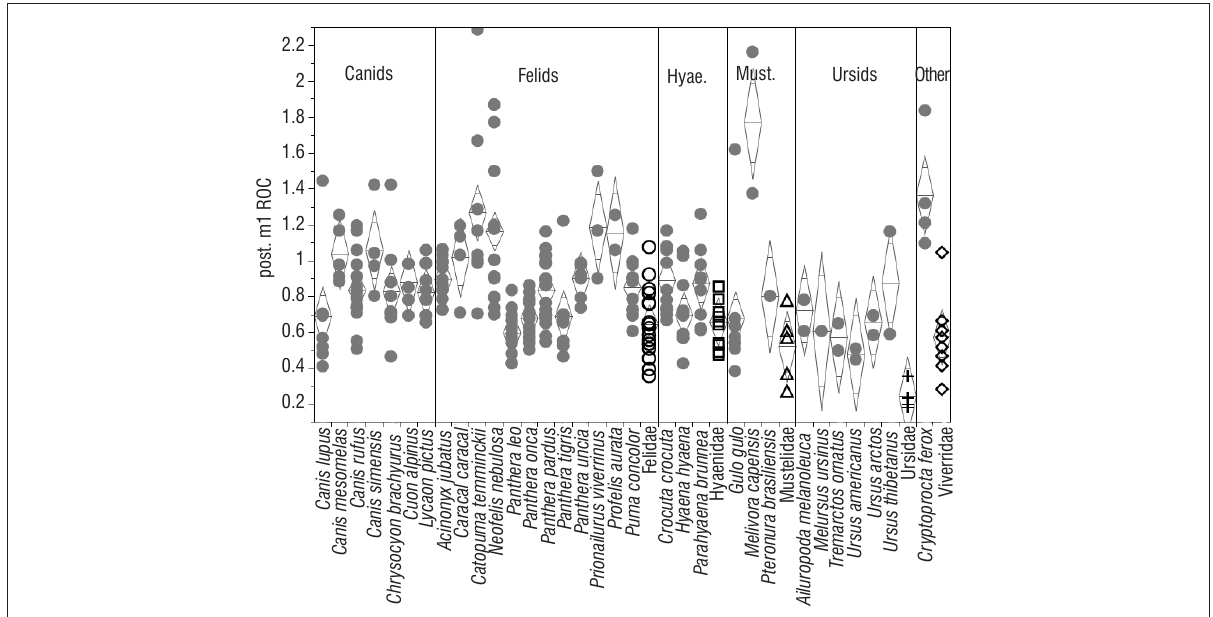
Extant taxa are represented by solid grey circles, Langebaanweg (LBW) felids by open circles, LBW hyaenids by open squares, LBW mustelids by open triangles, LBW ursids ( Agriotherium ) by ‘+’ signs, and LBW viverrids by open diamonds. Each dotted diamond represents the mean and 95% confidence interval vertical span; the horizontal lines are the mean and ‘overlap marks’ that indicate statistical separation. Figure 7: Radii-of-curvature (ROC) score of the posterior (protoconid) carnassial (m1) cusp by species.